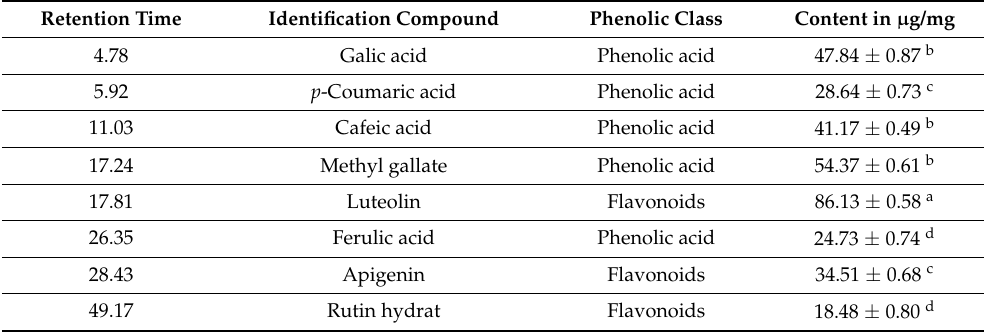
Table 1. Phytochemical identification by HPLC for total polyphenols extracted from leaves of W. adpressa